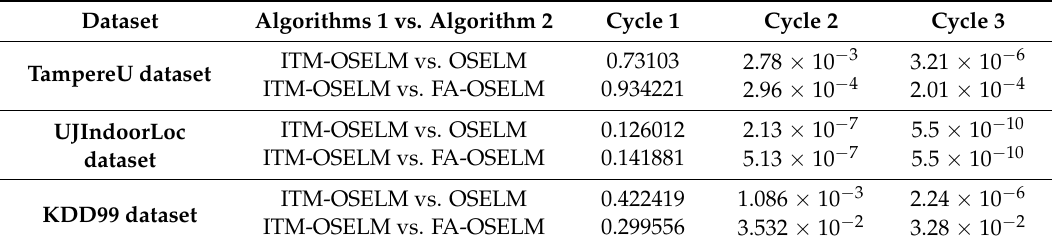
Table 4. Probabilities of the t -test for comparing ITM-OSELM with OSELM and FA-OSELM in each of the three cycles.